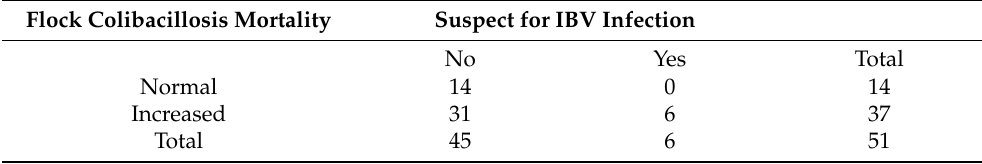
Table 9. Status of ILT infection among sampled flocks (ILT: infectious laryngotracheitis). Flock Colibacillosis Mortality Suspect for ILT